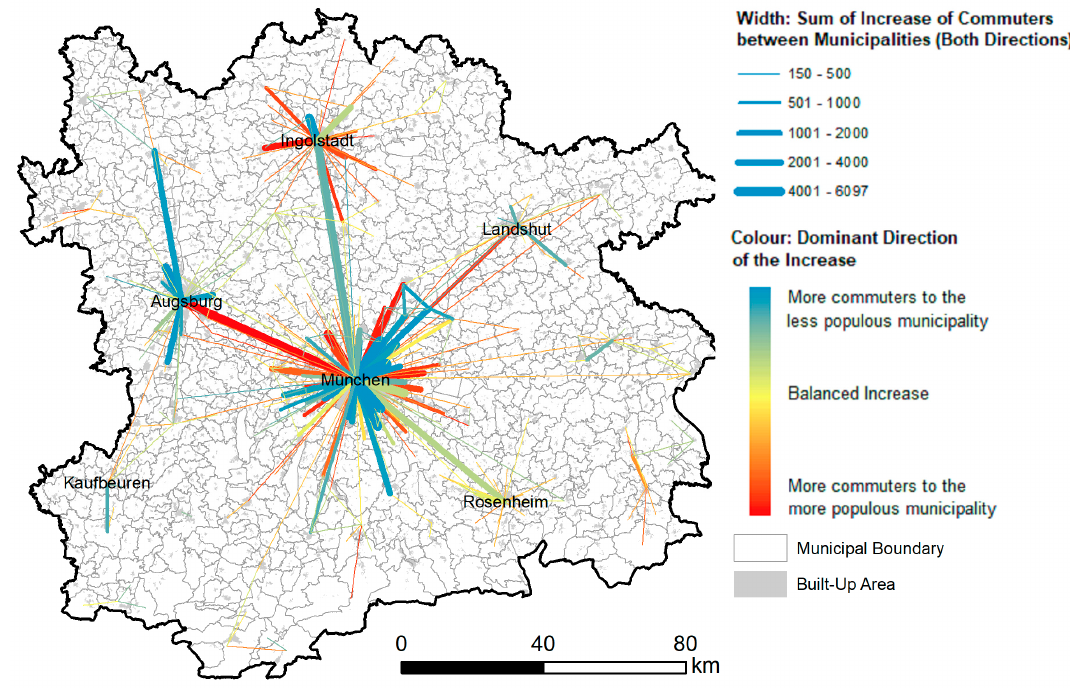
Figure 3. Dynamics of commuter relationships in the MMR between 2005 and 2018 (Source: own work, using geodata by Bayerische Vermessungsverwaltung, Bundesamt für Kartographie und Geodäsie, Bundesagentur für Arbeit).